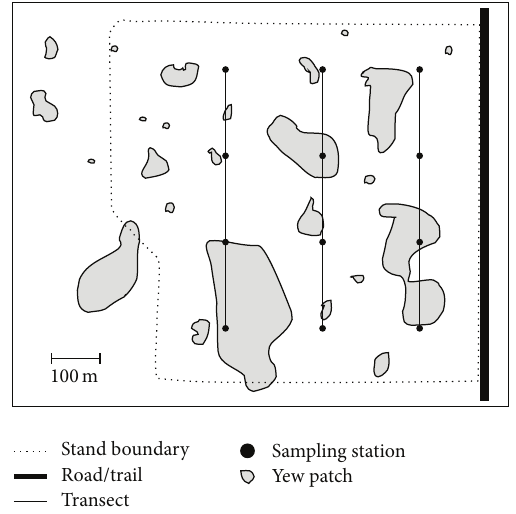
Figure 2: Typical arrangement of sampling transects and stations in relation to patches of Canada yew for 29 forested stands sampled in Marquette and Alger counties, Michigan,